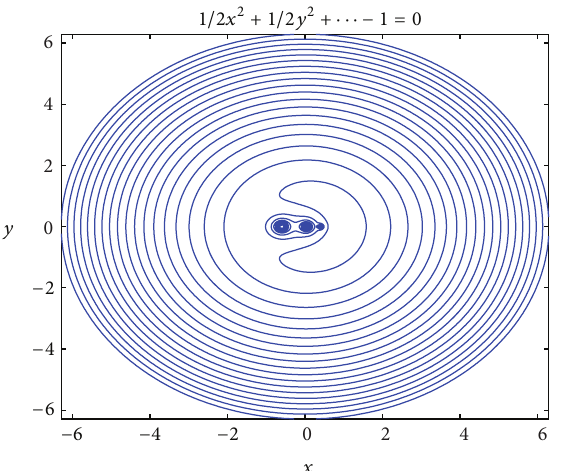
Figure 20: Curve of zero velocity (Xi Bootis-3) 𝑞 1 = 0.9988 , 𝑞 2 = = 0.1 , 𝐴 = 0.2 . 0.9988 , and 𝐴 1 2